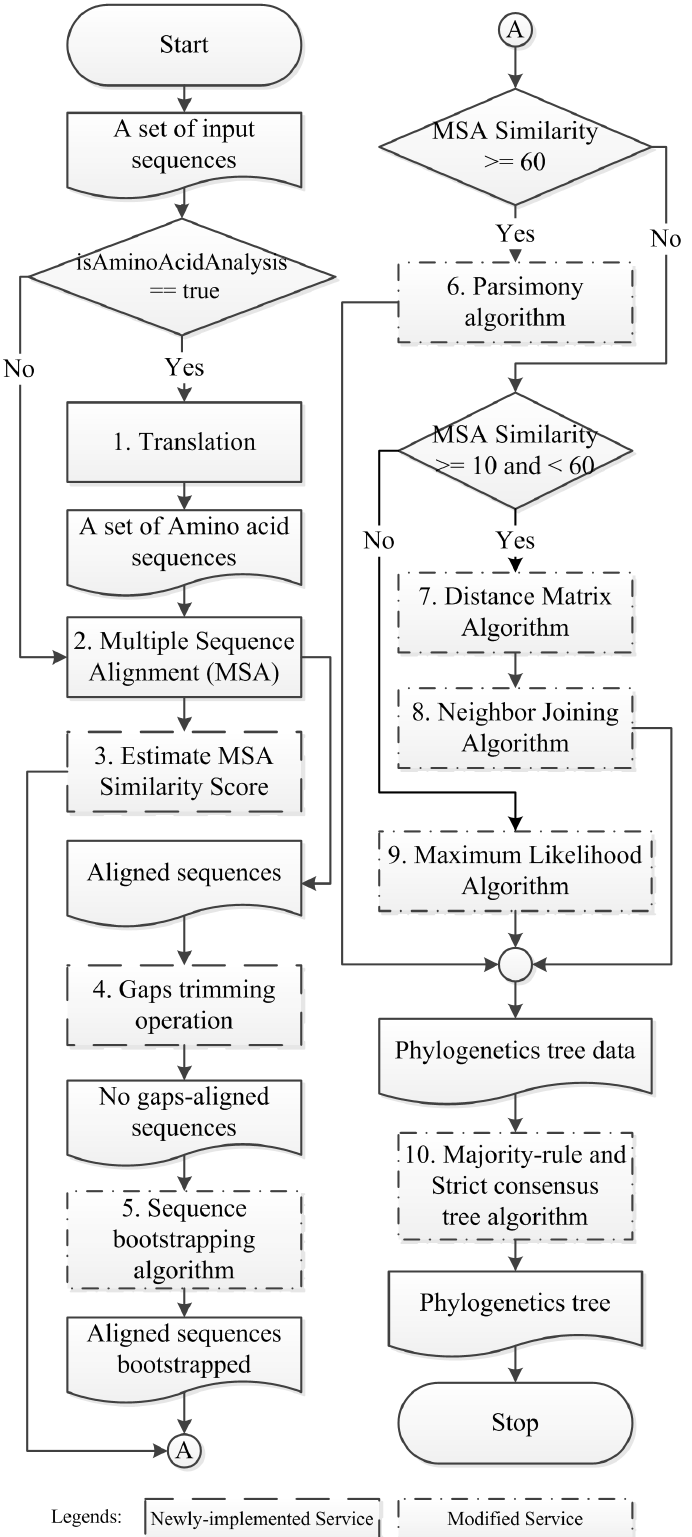
Figure 1: Our proposed practical steps for the phylogenetic tree